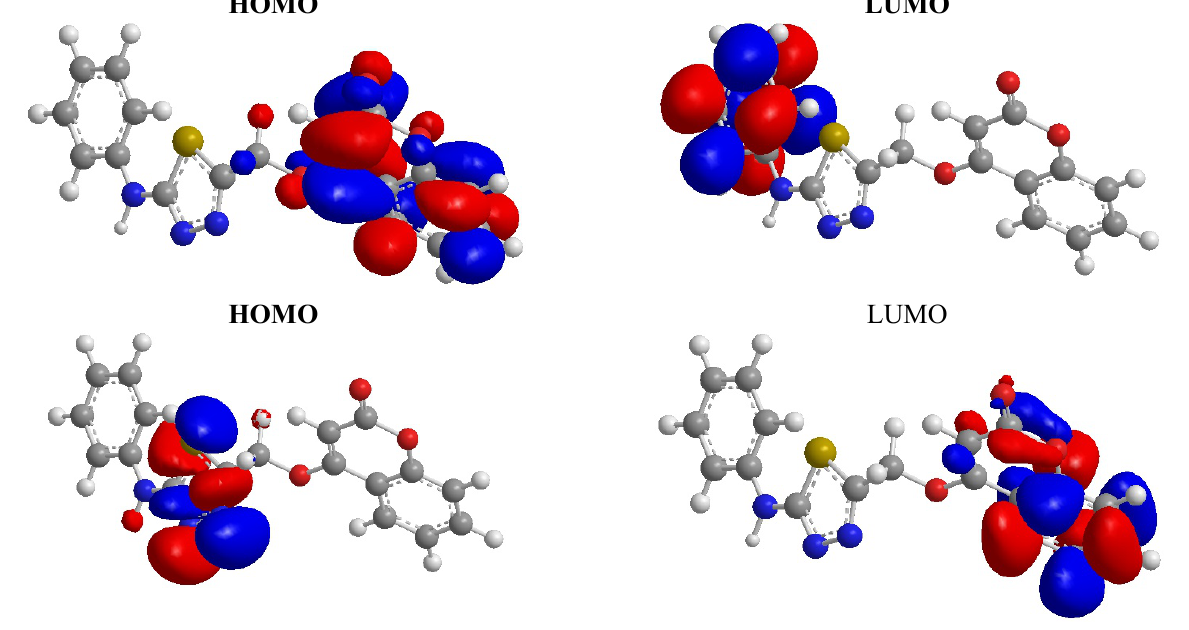
Figure 3. HOMO, LUMO, HOMO − 1 and LUMO +1 orbitals of 7 .